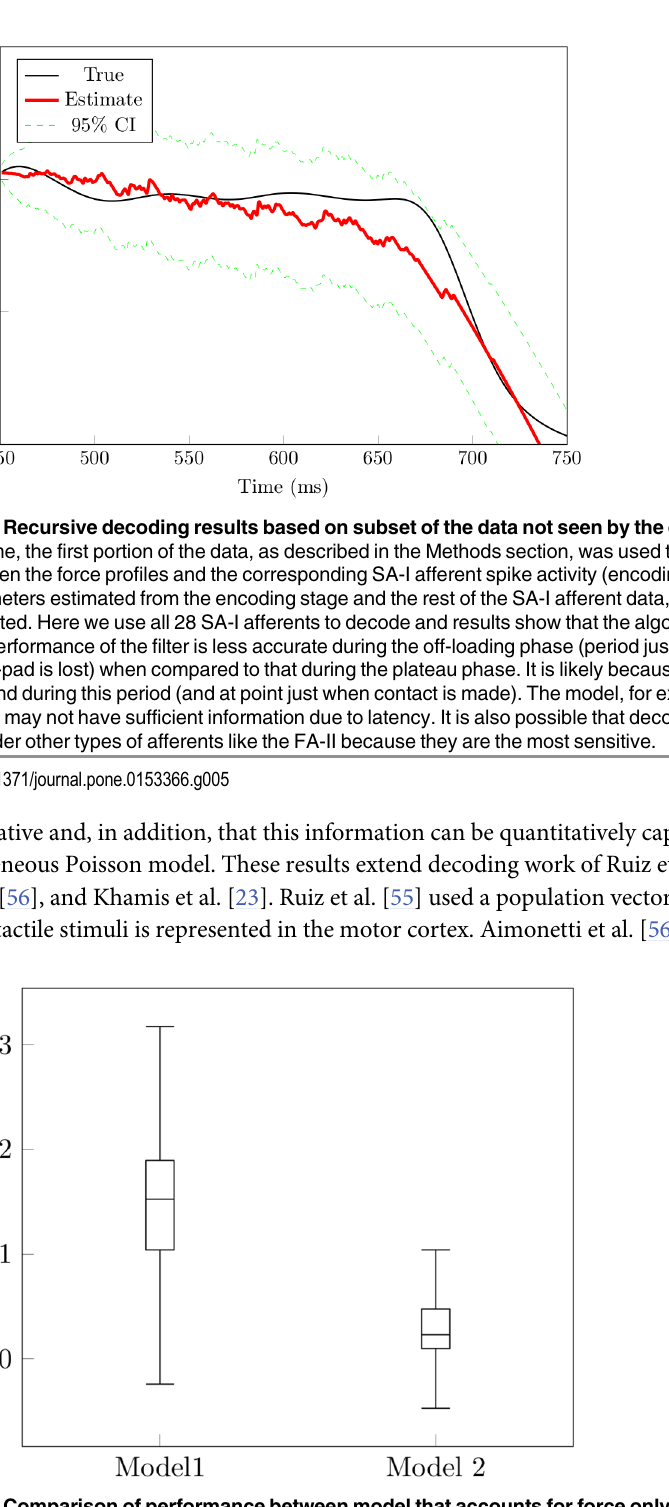
Fig 6. Comparison of performance between model that accounts for force only and model that accounts for force and the derivative of the force. In order to compare our model against a model that simply accounts for the force, we take the absolute difference between the true values and the predicted values for each model. Under this framework, the model that accounts for force derivative, in addition to force, performs